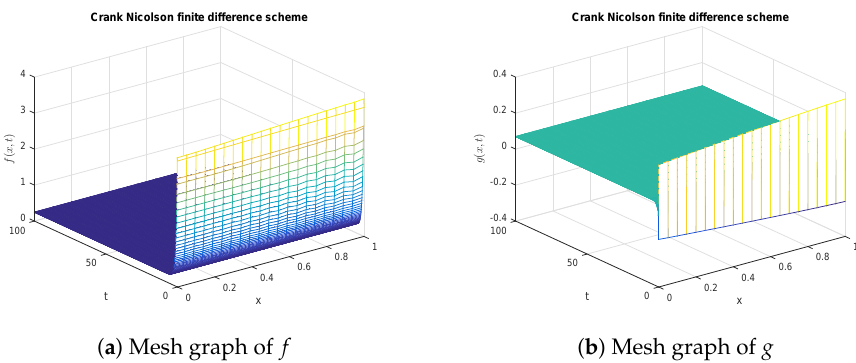
Figure 1. Graphical solution of f , g (concentration of substances) using Crank Nicolson method at a = 3.5, b = 0.25, χ 1 = 2, χ 2 = χ ∗